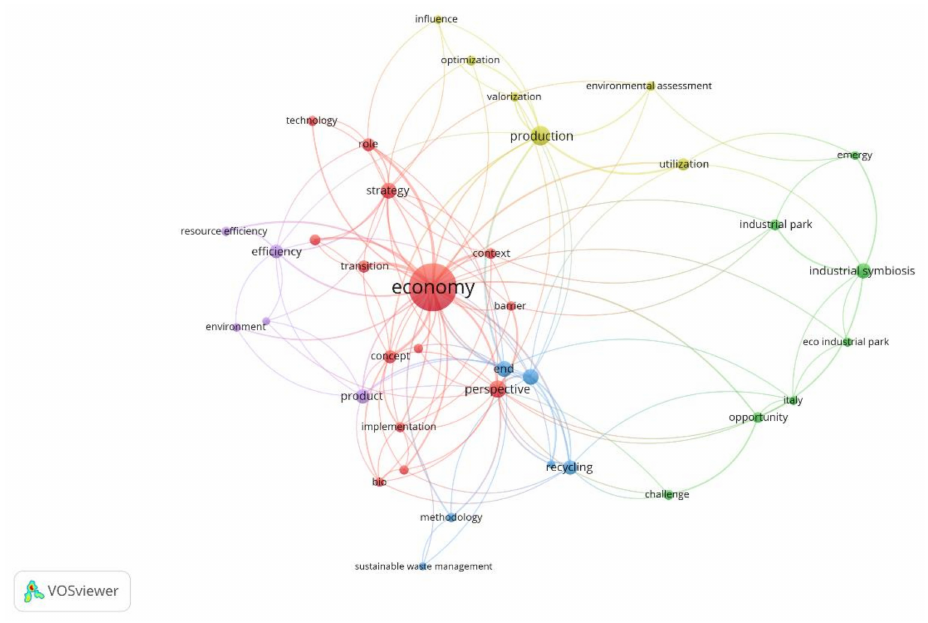
Figure 8. Map based on co-occurrence on the authors keywords from 2014 to